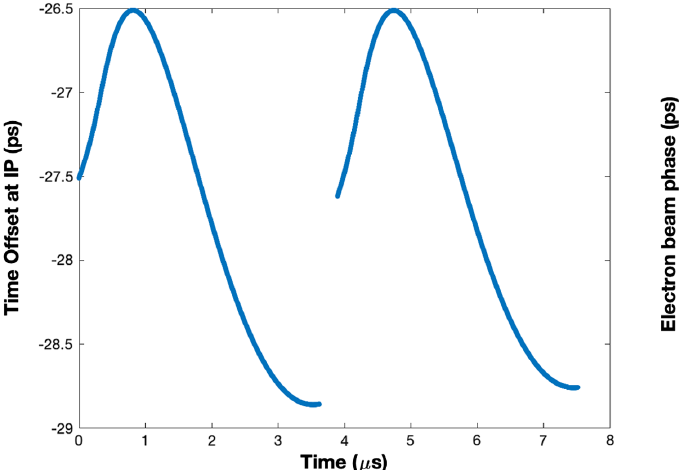
FIG. 6. Electron beam synchronous phase transient.